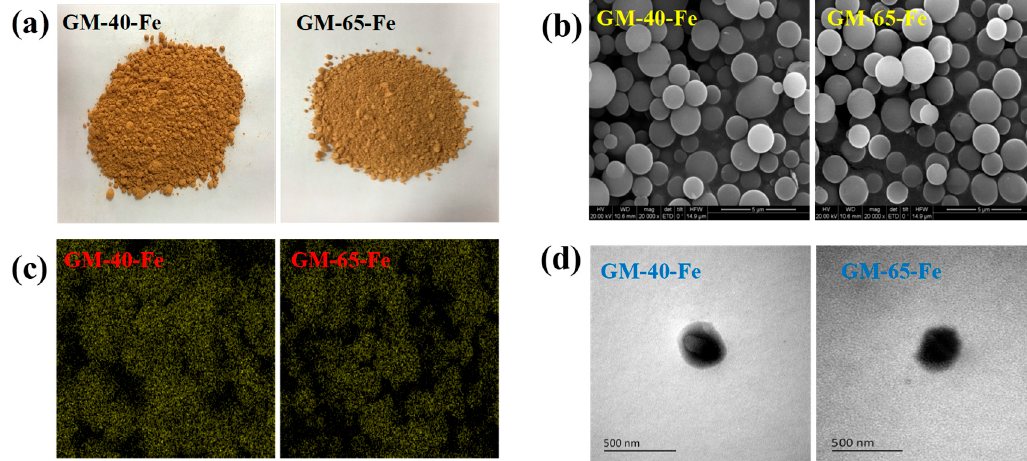
Figure 4. Morphological properties of galactomannan–iron(III) complexes. ( a ): visual images of galactomannan–iron(III) complex; ( b ): SEM images of galactomannan–iron(III) complex; ( c ): the distribution of iron in galactomannan–iron(III) complex; ( d ): TEM images of galactomannan–iron(III) complex.